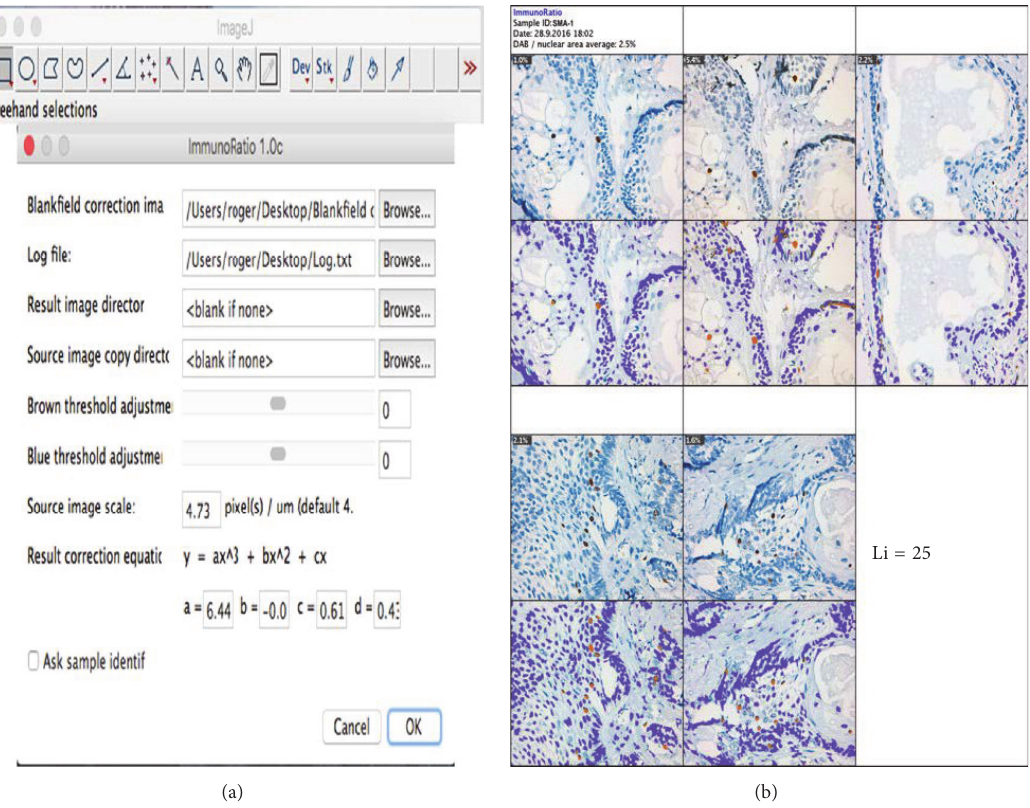
Figure 5: The advanced ImmunoRatio method using the ImageJ ImmunoRatio plugin. IRpA scoring: (a) changes introduced to the advanced ImmunoRatio method were obtained from the online advanced ImmunoRatio method. (b) Photomicrographs of a solid ameloblastoma specimen at 400x magnification. This photomicrograph represents the advanced ImmunoRatio method for determining the labeling index. ThismethodwasmodifiedaccordingtoBologna-Molinaetal.[7].Theresultsarefromfivephotomicrographs.Eachoriginalphotomicrograph